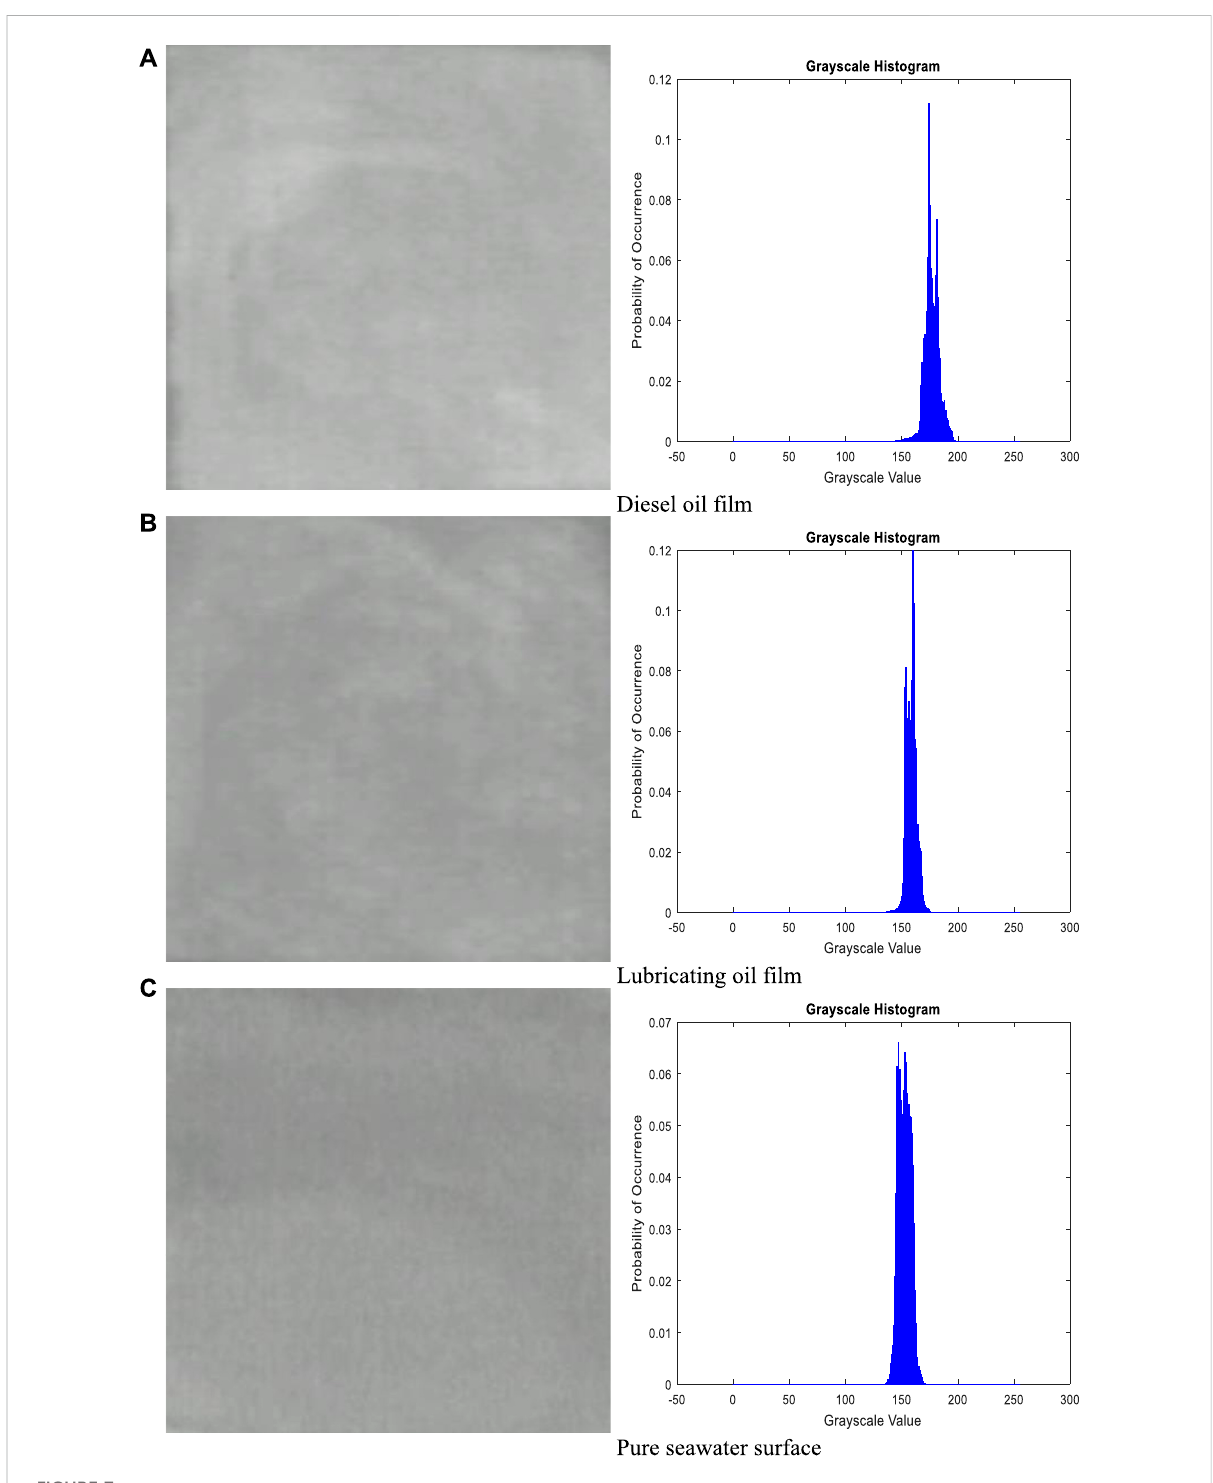
FIGURE 7 Remote sensing images of different types of oil fi lm. (A) Diesel oil fi lm (B) Lubricating oil fi lm (C) Pure seawater